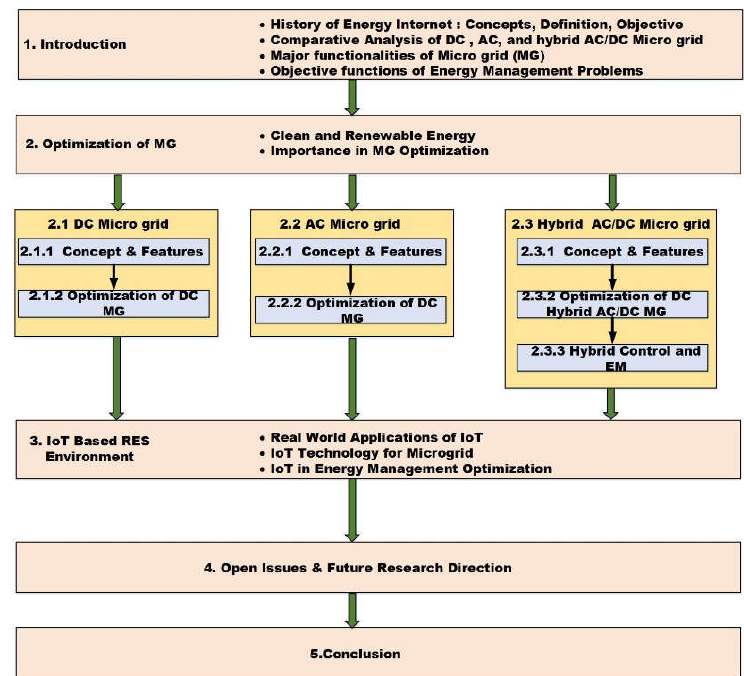
Figure 1. Framework of the paper.